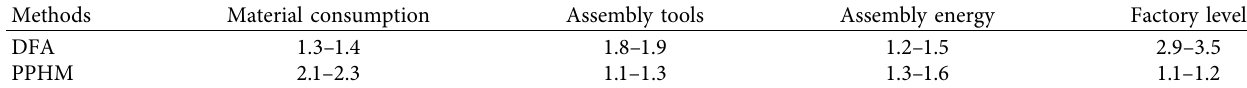
Table 3: The cost evaluation of two